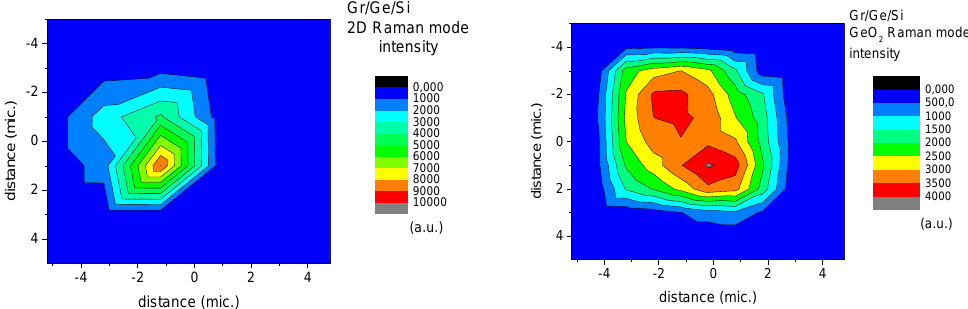
Figure 9. The maps of Raman intensity of the 444 cm − 1 line due to GeO 2 ( right map) and the corresponding map of the 2D peak intensity ( left map) measured on one of the blisters.